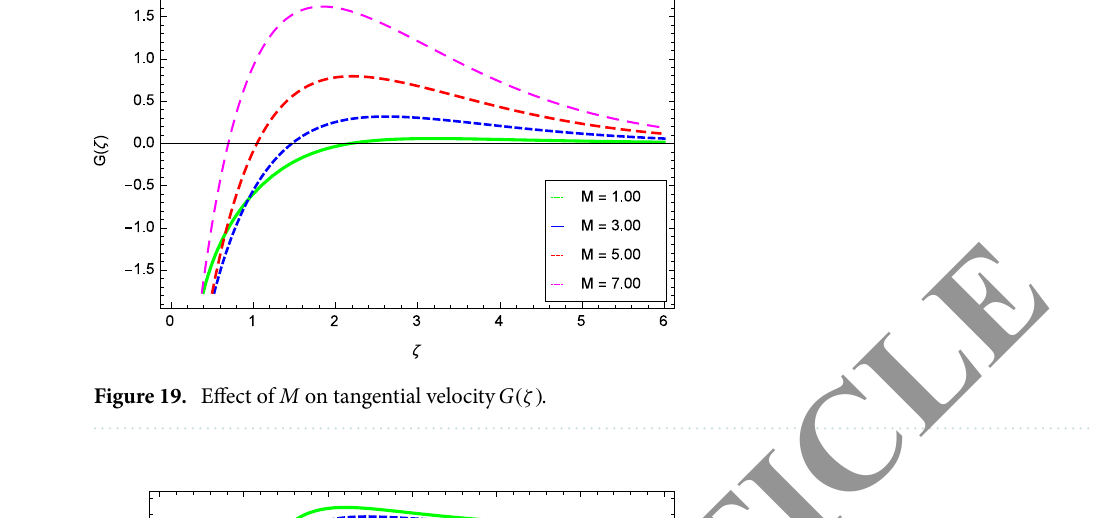
Figure 20. Effect of m on tangential velocity G (ζ) .